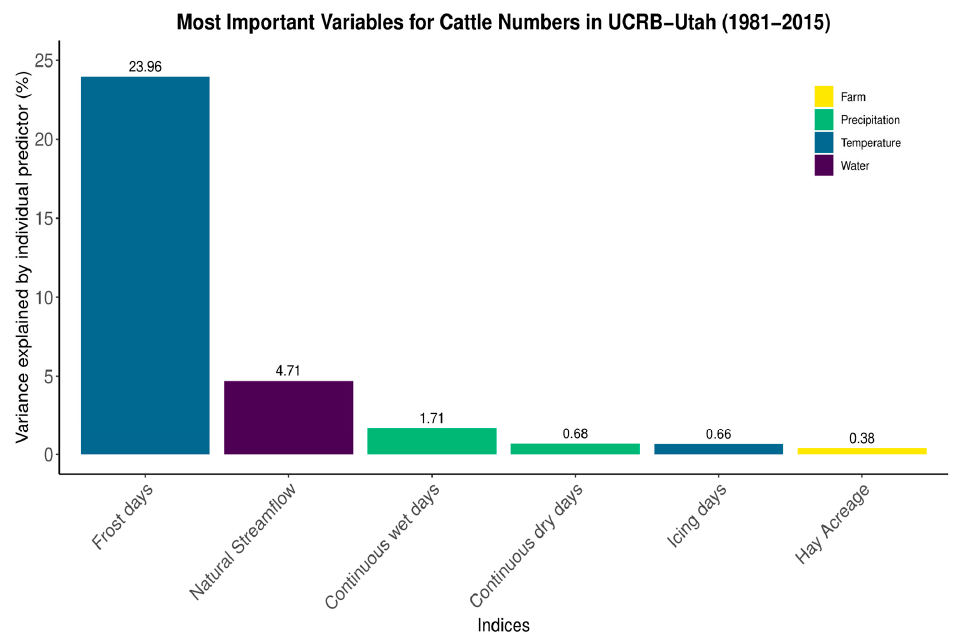
Figure 6. Most important variables for cattle numbers in UCRB-Utah (MLR).